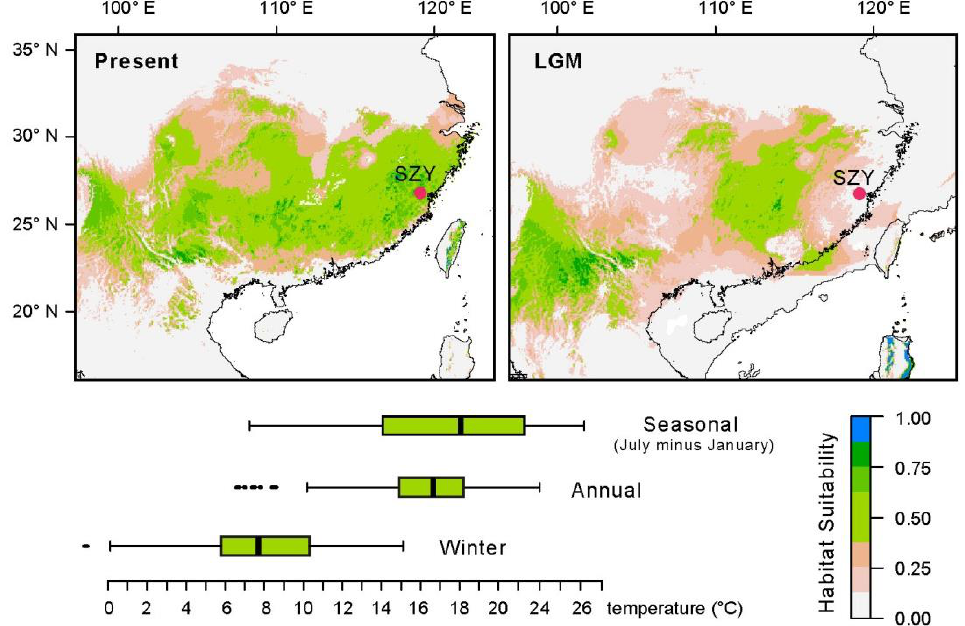
Figure 4. Potential distribution of evergreen broadleaved forest (EBLF) in southern China simulated by Maxent. The quantile result of critical climate thresholds for the simulated present distribution is shown below. The suitability value ranges from 0 (unsuitable) to 1. The green to blue distribution ranges represent the predicted most probable climatic-suitable habitats for the